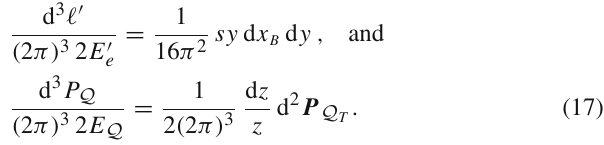
/ψ ( 1 S ) | 0 (cid:3) 0 8 ) , where the QQ s ( 1 ) configuration in asso- 1